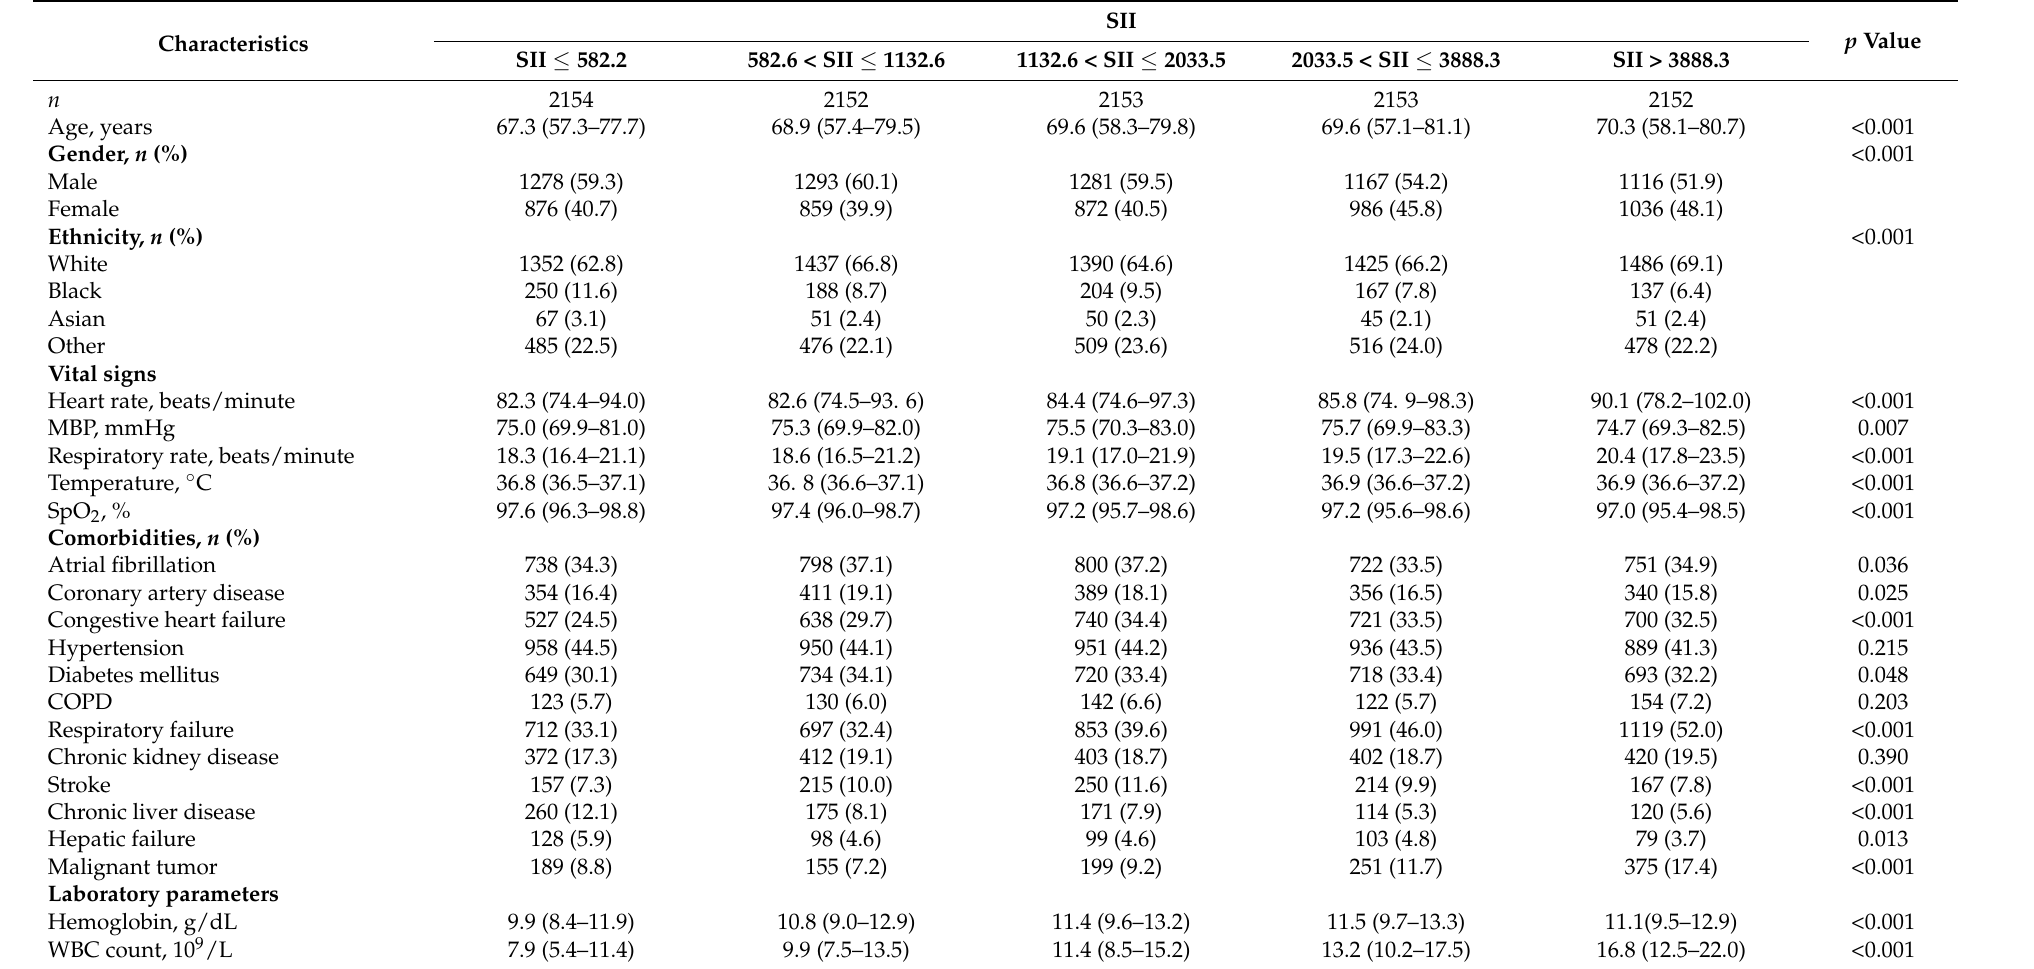
Table 1. Baseline characteristics of the study